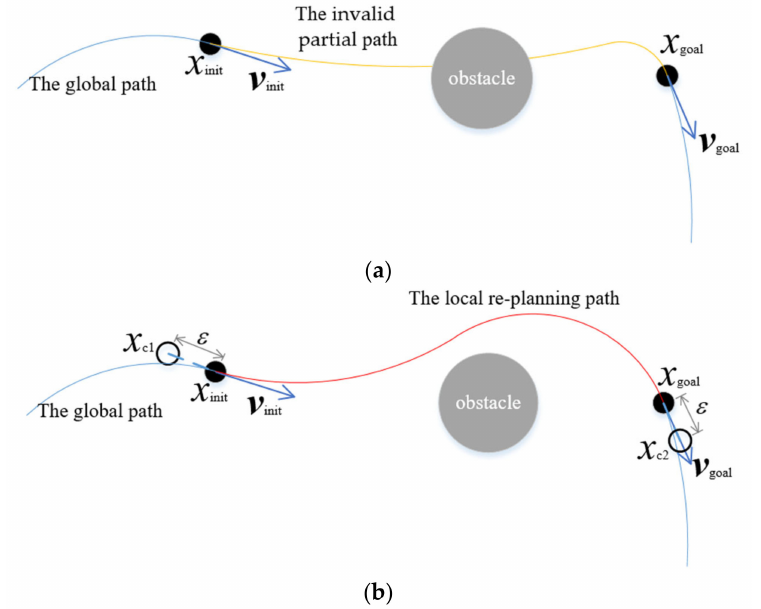
Figure 4. The GRPS provides the local re-planning path based on the EPOC method. As the ε → 0, the x c1 and x c2 are the control nodes of the path end orientation constraint. ( a ) The partial path is invalid due to an environmental change. ( b ) The local re-planning path with the end orientation constraint replaces the invalid path and smoothly merges into the global